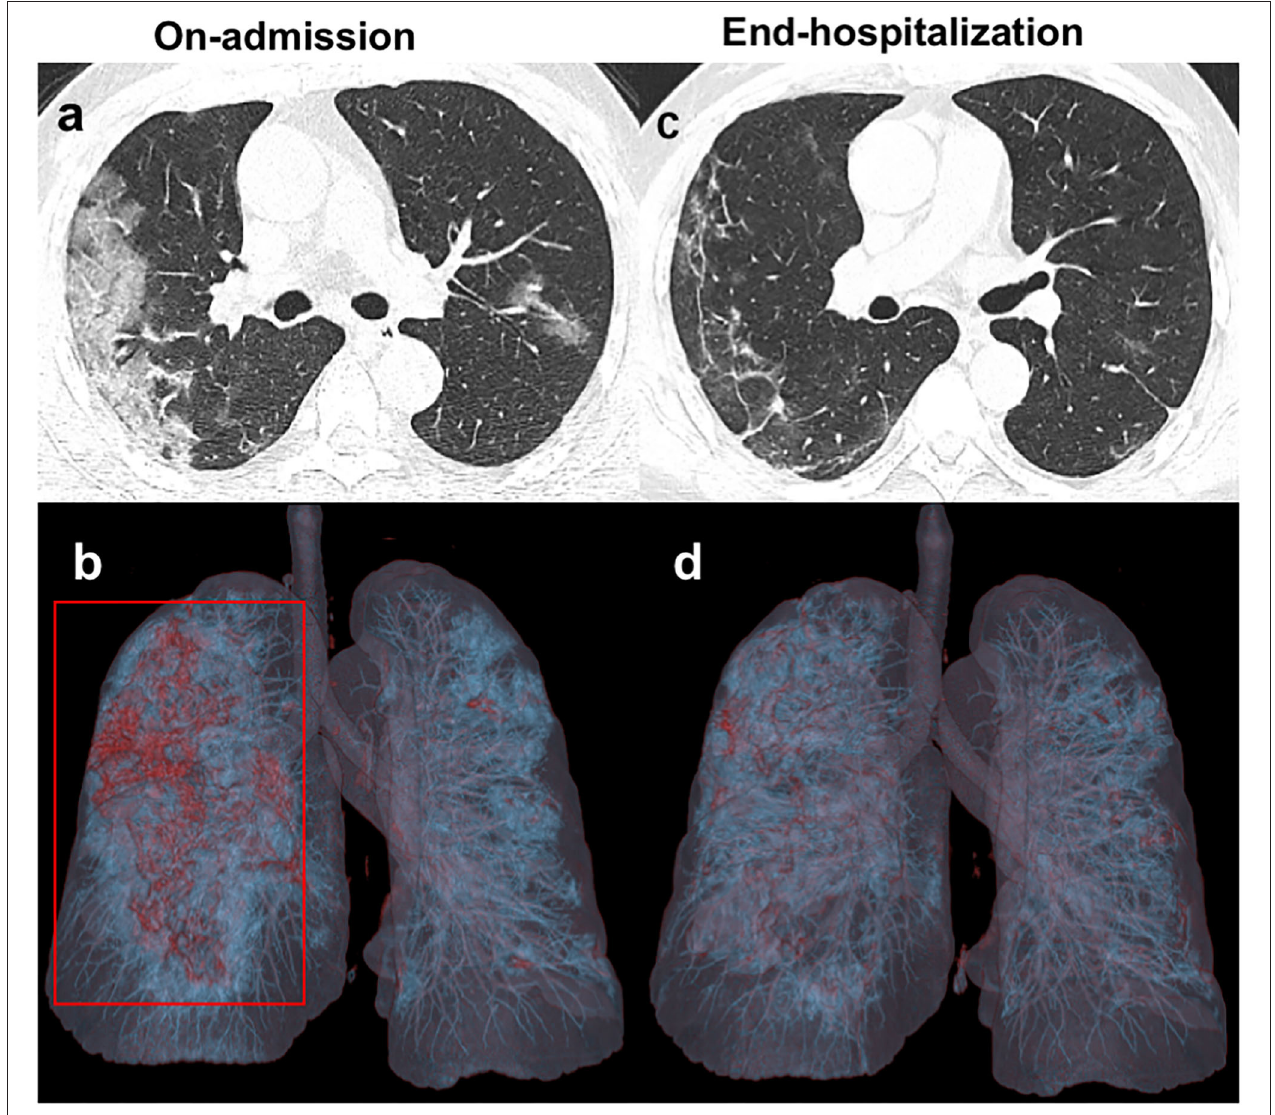
FIGURE 1 | Unenhanced chest CT images of a 41 years old patient infected with COVID-19 from the NF group. (a,b) Axial images obtained on-admission show extensive ground-glass opacities (GGO) in the subpleural regions of both lungs. Three-dimensional volume-rendered reconstruction (3D-VR) image mainly presents as a red lesion in the right lung (red box). (c,d) Follow-up CT images obtained at end- hospitalization show significant absorption of GGO with irregular linear